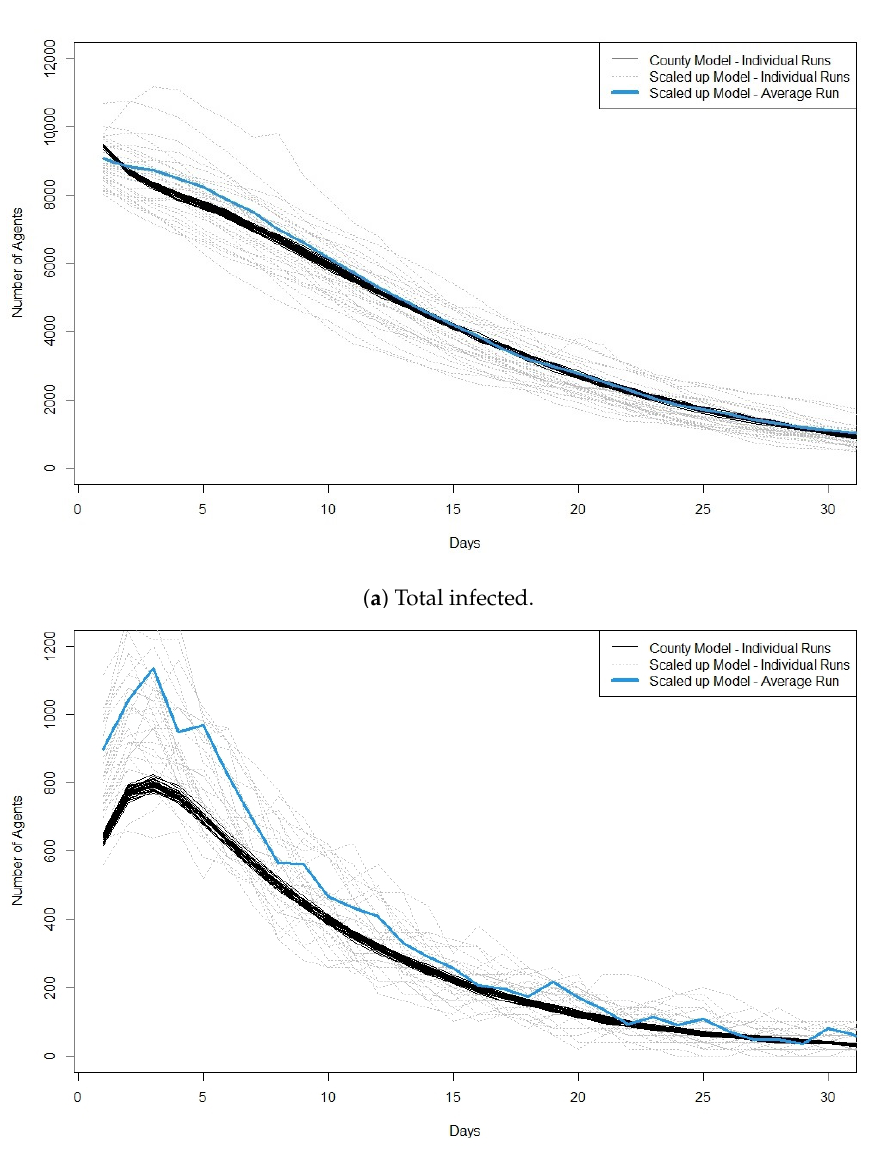
Figure 3. Plots showing cross validation results when 10,000 agents are infected at the start of the run in the original model and 100 agents are infected at the start of the run in the scaled model. ( a ) shows the total number of infected agents per day and ( b ) shows the newly infectious agents per day. For the scaled model the y -axis is the number of infected × 100. We also plot the average value across the 30 runs of the scaled model. Best viewed in